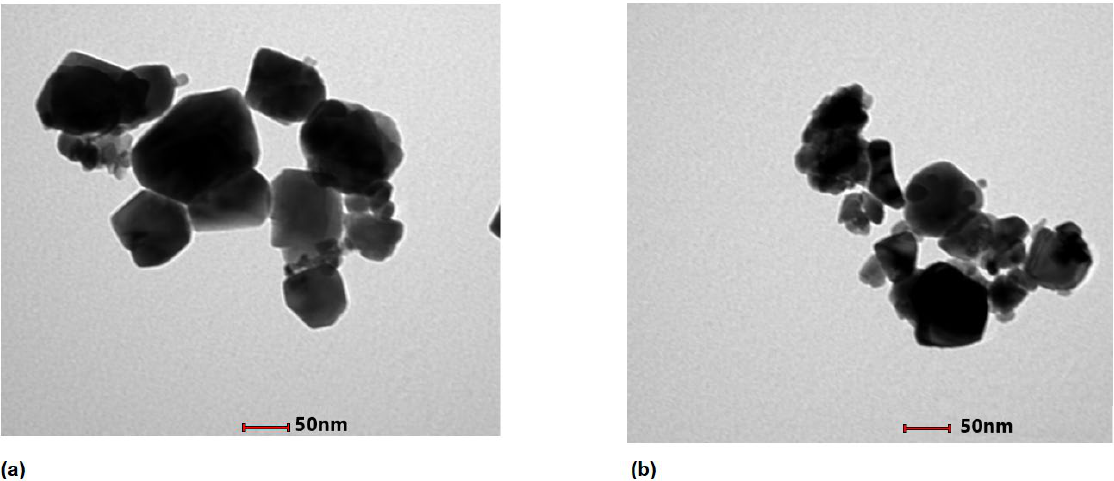
Figure 2. Transmission electron micrographs of ( a ) bacteriogenic CuO nanoparticles and ( b ) bacte- riogenic ZnO nanoparticles synthesized by Stenotrophomonas maltophilia using JEOL -2100TEM with a scale bar of 50 nm.